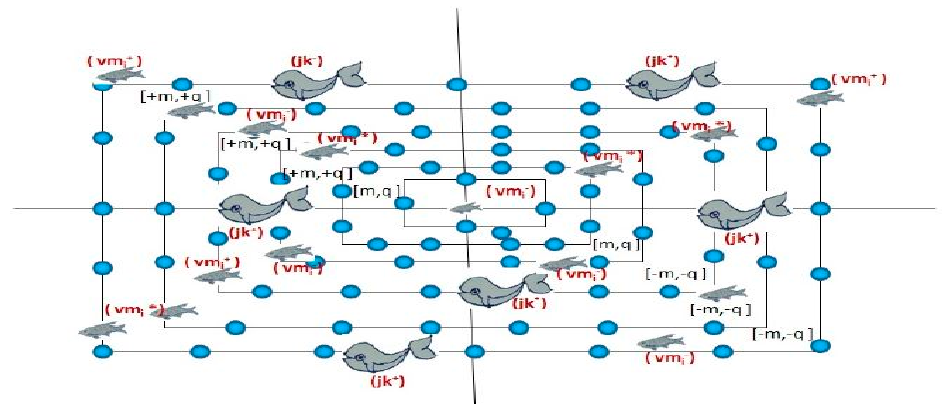
Figure 11. Bubble net hunting strategy of whale optimization load balancing technique [91]. The steps involved are presented in the algorithm.